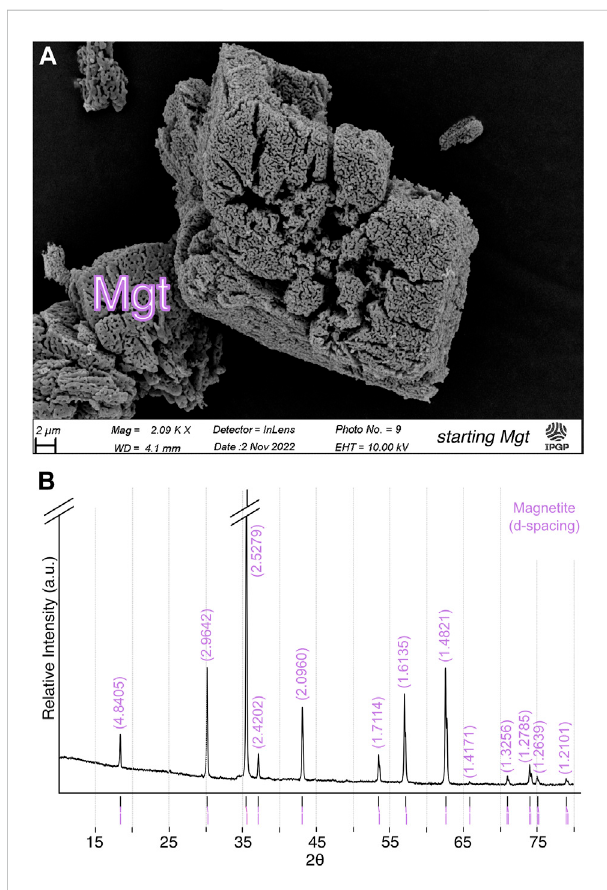
FIGURE 1 (A) SEMimageand (B) XRDanalysisofthestarting magnetite.Mgt refers to magnetite. Please note the narrowness and the highness of the diffraction peaks that highlight the quality of the crystallinity. A zoomed image of the starting magnetite surface is provided in Figure